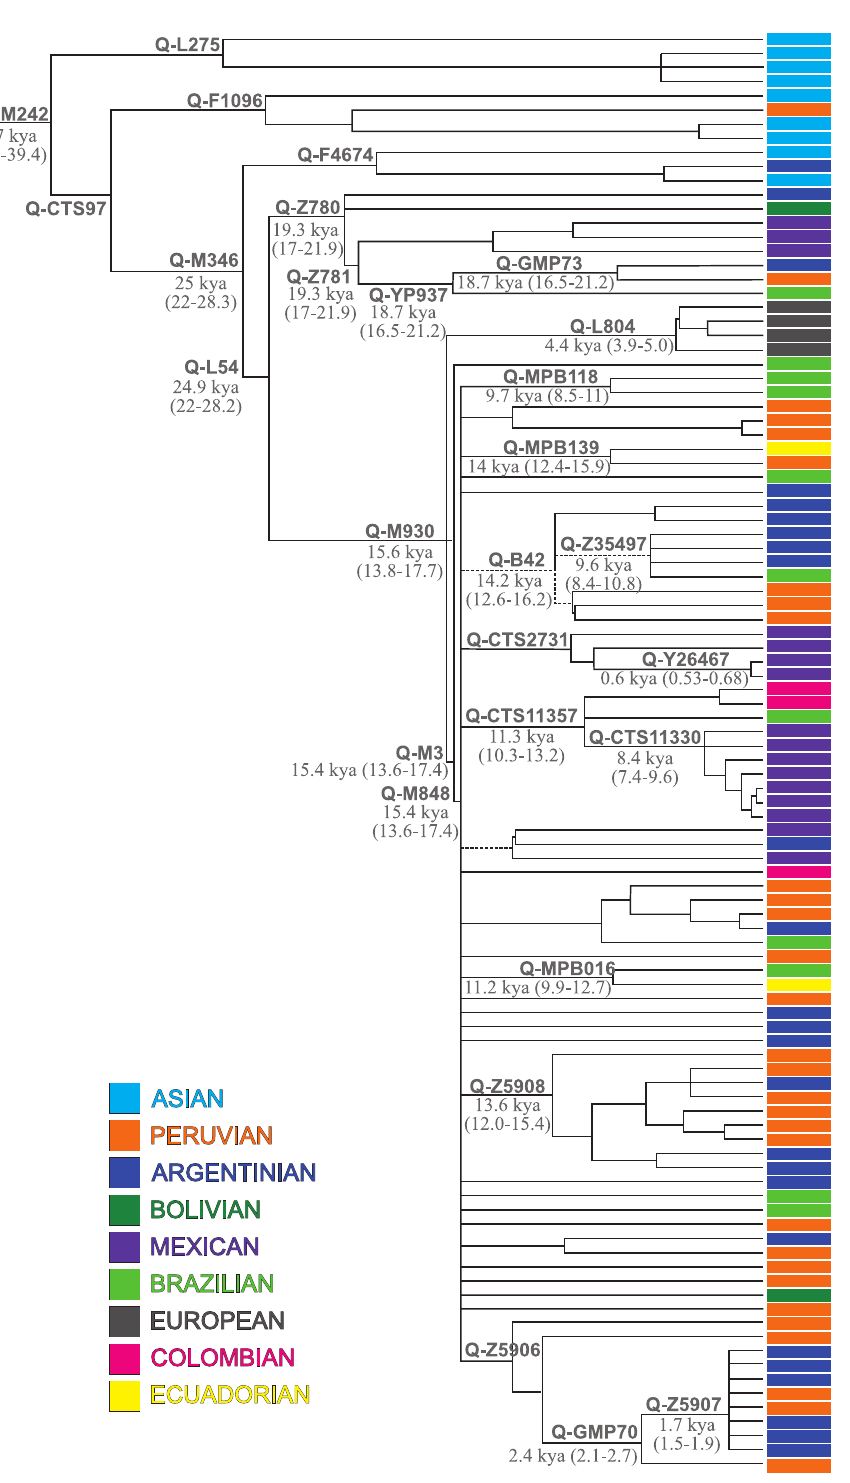
Fig 1. Q-M242 haplogroup phylogeny reconstructed with 102 Y chromosome sequences. The colors in the tree box represent each individual and are in accordance with the macro-area or the country according to the box on the left. Divergence times estimated in this study are represented in italics, in kya, and with a 95% confidence interval between parentheses (for more details see Methods). Dashed lines are used to represent branches that require further study for a better definition. For more information on data set, see Table A in S1 Text and S1 Table, and for more detailed phylogenetic representation, see S5 Fig. https://doi.org/10.1371/journal.pone.0271971.g001 PLOS ONE | https://doi.org/10.1371/journal.pone.0271971 August 17,